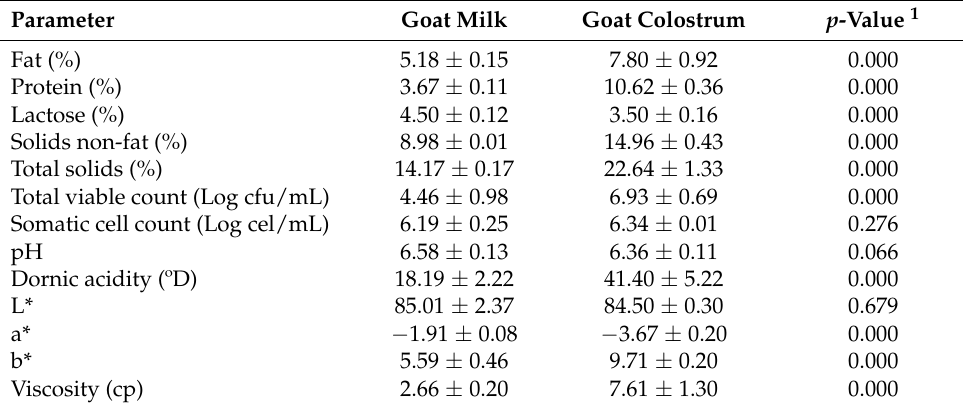
Table 1. Means and standard deviations of some traits of the raw materials used to manufacture yogurt-type fermented products (n = 4).